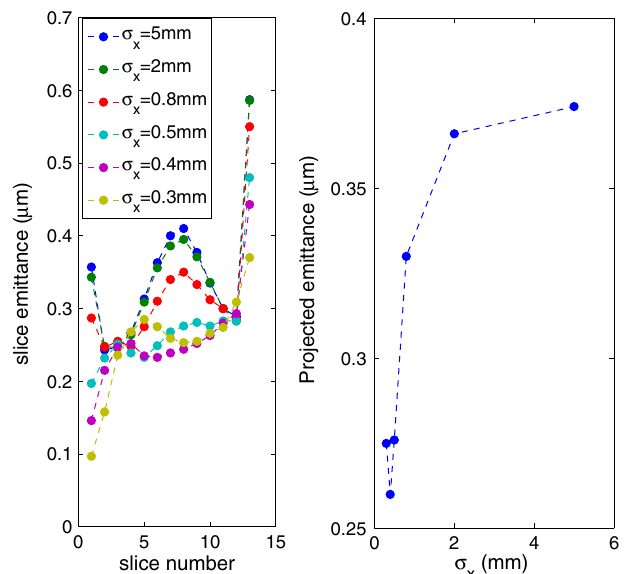
FIG. 2. Projected (left) and time-sliced (right) emittances with the pure uniform ( (cid:2) x ¼ 5 : 0 mm and 2.0 mm), nearly uniform ( (cid:2) x ¼ 0 : 8 mm ), and different truncated-Gaussian beams ( (cid:2) x ¼ 0 : 5 , 0.4, and 0.3 mm) for a 150 pC bunch charge. Note that 5% particles in the tails are excluded in the emittance